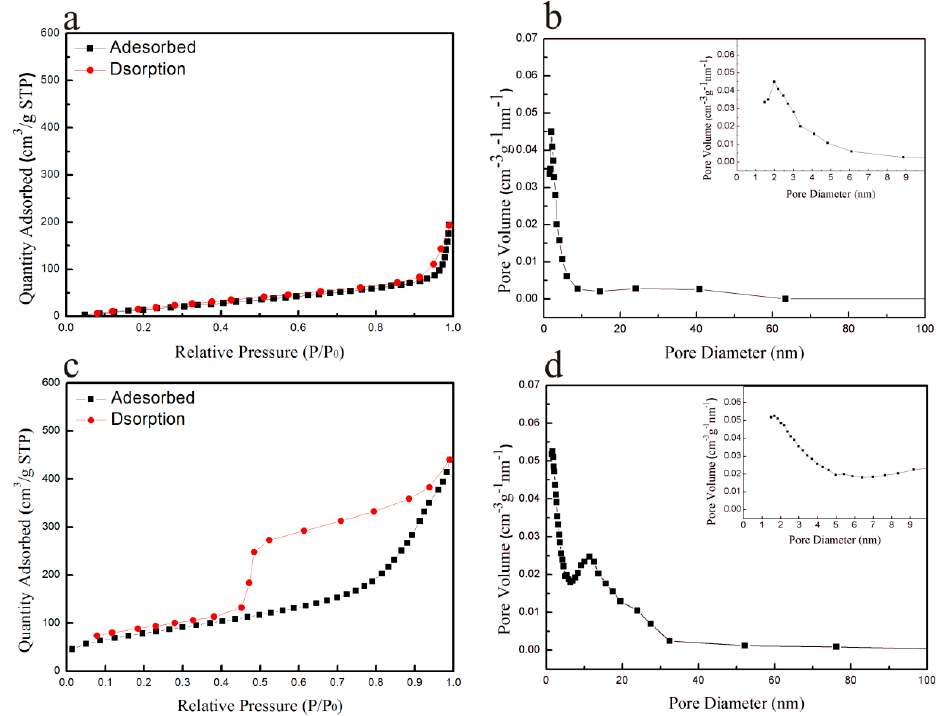
Figure 4. ( a ) N 2 adsorption-desorption isotherms of the CNF; ( b ) pore diameter distribution of the CNF; ( c ) N 2 adsorption-desorption isotherms of the PCNF; ( d ) pore diameter distributions of the PCNF.